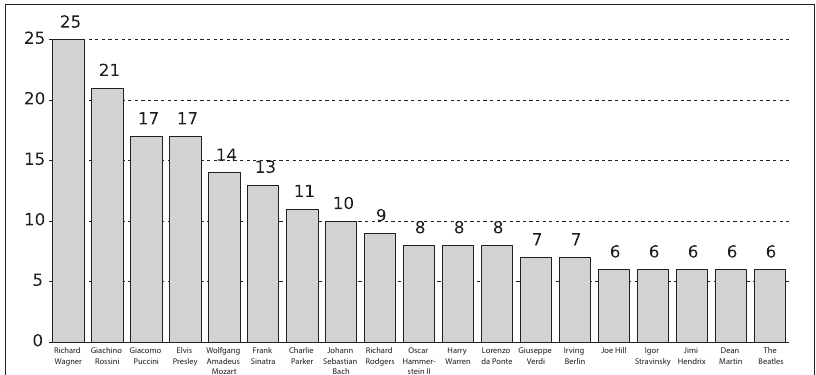
Figure 11: Most frequently referenced composers and